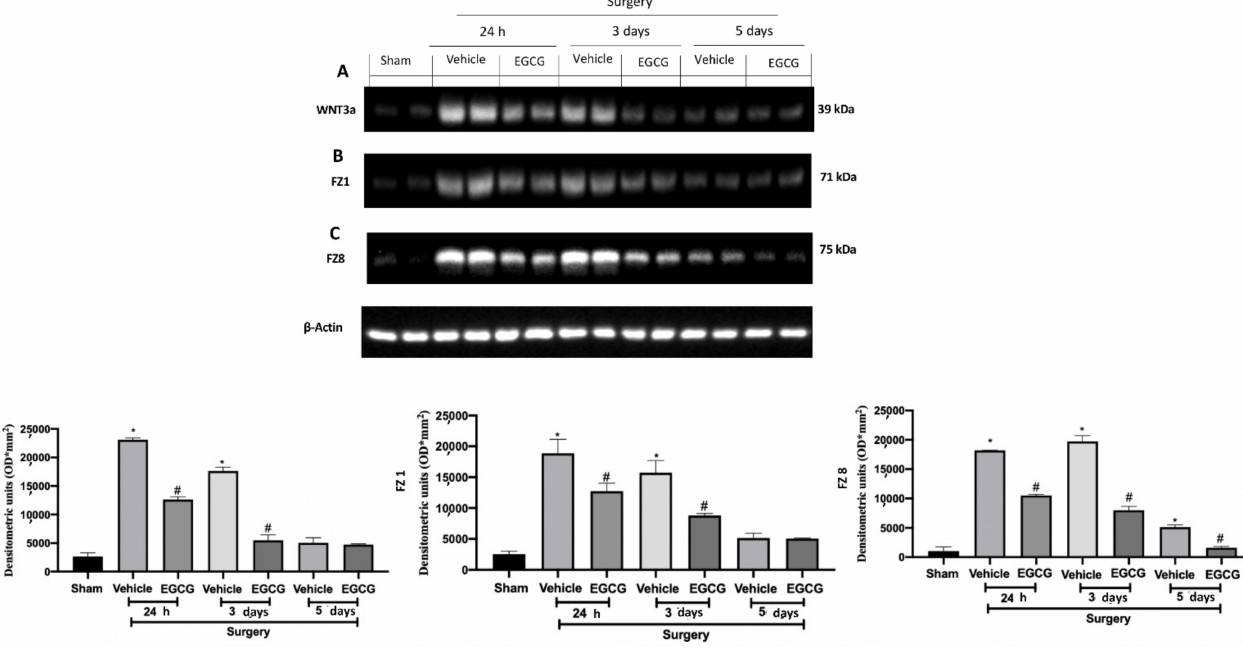
Figure 2. EGCG administration reduced WNT/FZ/ β -catenin pathway activation: Western blot analysis of: WNT3a ( A ), FZ1 ( B ), FZ8 ( C ) expression. A p -value of less than 0.05 was considered significant. * p < 0.05 vs. sham, # p < 0.05 vs.